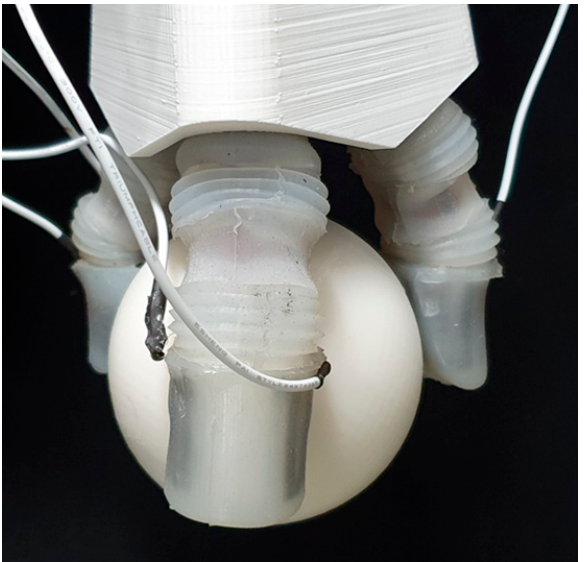
Figure 18. Gripper holding a spherical object in adhesion experiment.